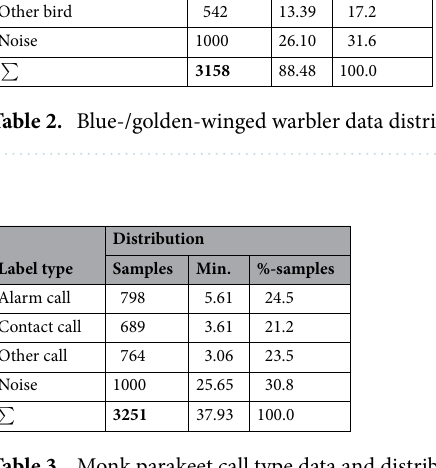
Table 3. Monk parakeet call type data and distribution. Significant values are in bold.